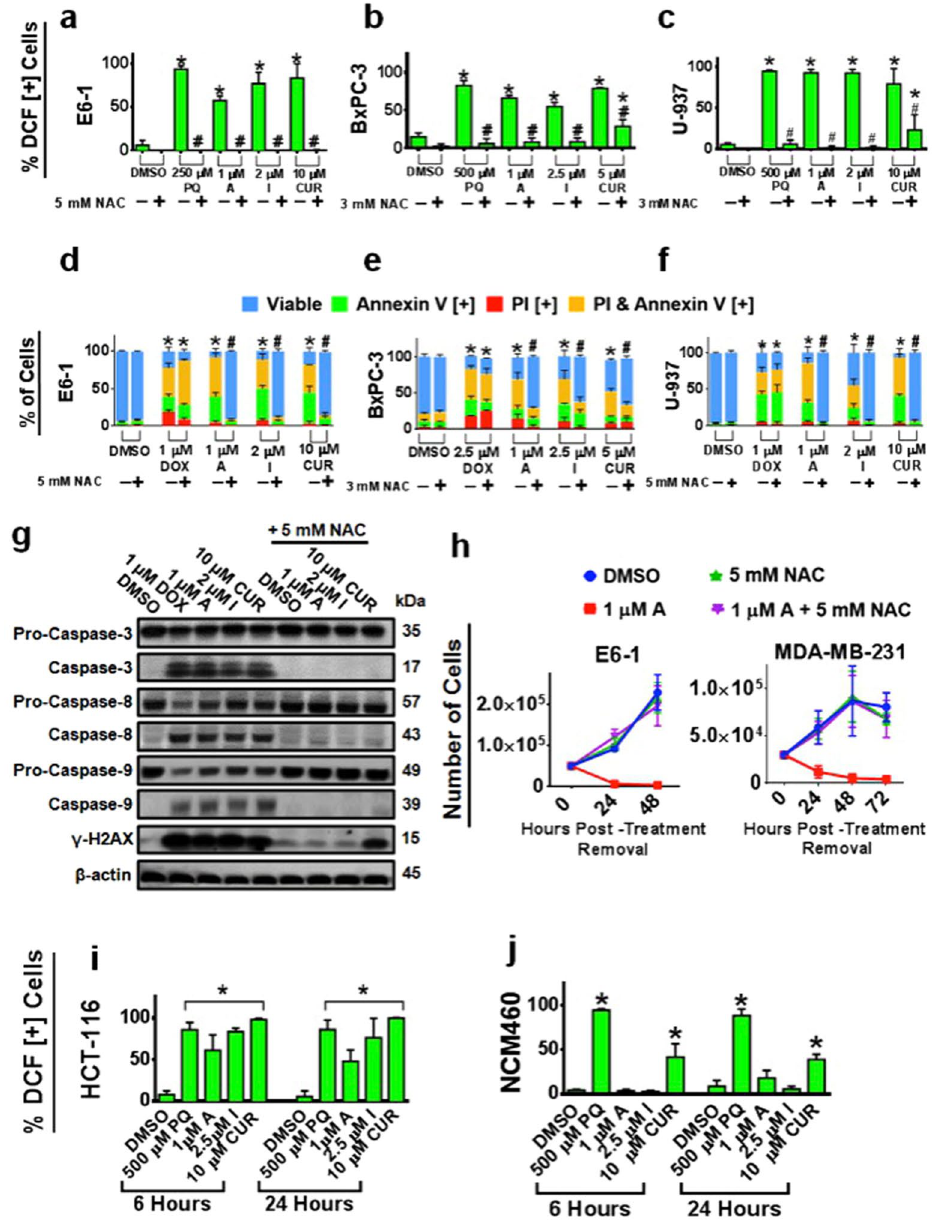
Figure 6. Curcumin Analogs are Dependent on the Production of Oxidative Stress to Induce Apoptosis. ( a–c ) Blood cancer (E6-1 and U-937) and pancreatic cancer (BxPC-3) cell lines were treated with H 2 DCFDA following treatments with or without the antioxidant, NAC and the studied compounds for 3 hours. Results were obtained using the image-based cytometry with the Y-axis representative of percent of cells positive for DCF. ( d–f ) Cancerous cell lines were treated with or without the antioxidant NAC for 48 hours. Following treatment, cells were stained for Annexin V and PI. Results were obtained using image-based cytometry with the Y-axis representative of percent of cells positive for Annexin V (green), PI (red), Annexin V and PI (yellow), or negative for both Annexin V and PI (blue). ( g ) E6-1 cells were treated for 24 hours with or without NAC and the studied compounds, lysed and subjected to Western blot analysis. Bands were visualized with a chemiluminescence reagent. ( h ) Cells were treated with the studied compounds for 24 or 48 hours respectively. Treatments were then removed and each group was replaced with media. Following 24, 48, or 72 hours, cells were counted using trypan blue. ( i – j ) Colorectal cancerous cells (HCT-116) and normal colon cells (NCM460) were treated with the studied compounds and monitored for the production of ROS at 6 and 24 hours using H 2 DCFDA. Results were obtained using the image-based cytometry with the Y-axis representative of percent of cells positive for DCF. All graphical values are expressed as a mean ± SD from three independent experiments. Statistical calculations were performed using Two-Way ANOVA multiple comparison for ( d-f ) and One-Way ANOVA multiple comparison for (a–c , i–j ). * p < 0.05 vs % viable or DCF [ + ] cells of Control (DMSO); # p < 0.05 vs % viable or DCF [ + ] cells of groups treated without